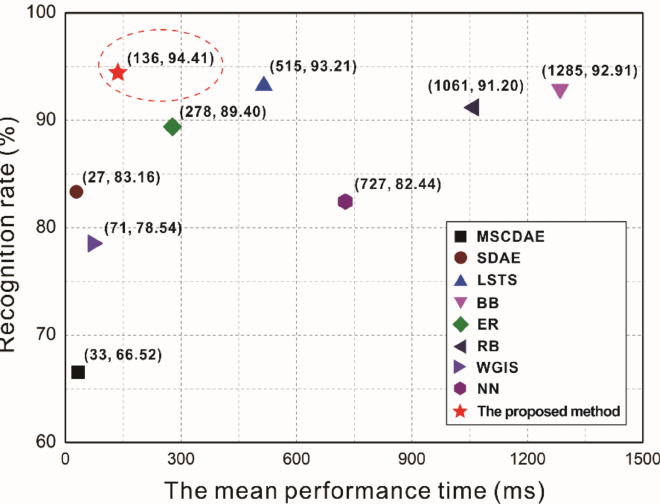
Figure 15. Comparison of different recognition methods (MSCDAE [40], SDAE [41], LSTS